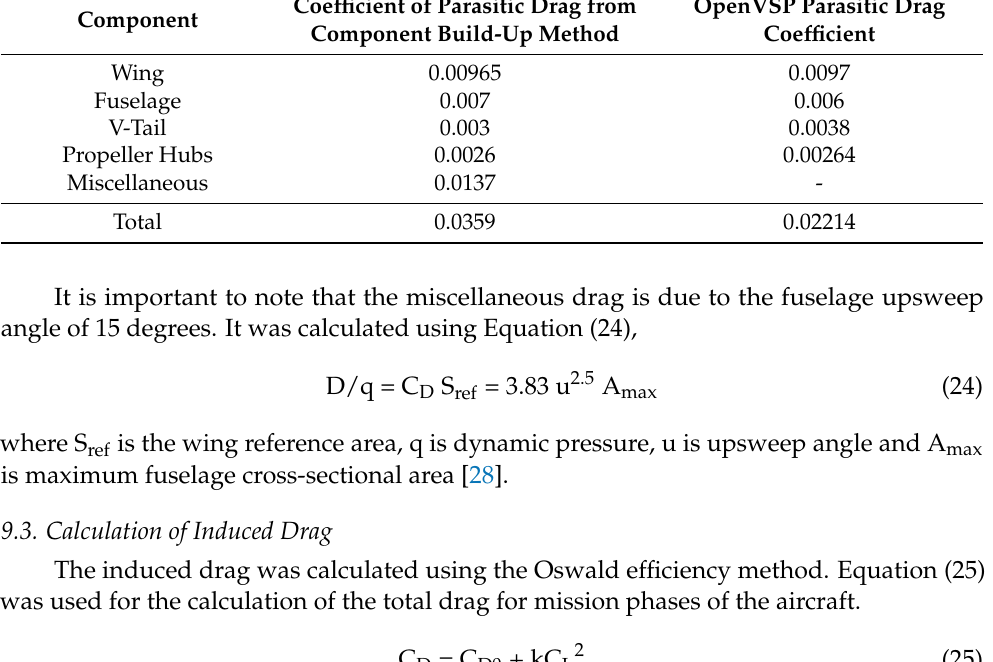
Figure 20. Lift coefficient for the wing versus angle of attack. Table 11. Drag contributions by various components.